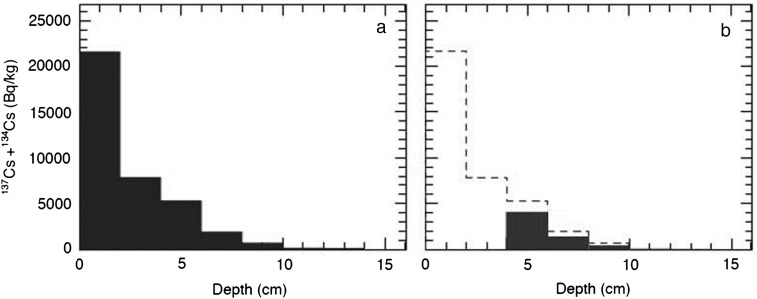
Decontamination of the rice field [1,2]. Radioactive Cs was only adsorbed onto the fine clay part of the soil; hence, it took time to sediment when water was introduced to the field and mixed with the surface soil. After mixing the surface soil with water, first the larger particles settled out, but the fine particles remained suspended in the supernatant. At this stage the fine particles suspended in the water were separated off into the ditch prepared next to the farming field, leaving most of the non-contaminated soil behind. Through this method, >80% of the radioactivity was removed: a: before treatment, b: after the removal of the supernatant. The radioactive Cs remained on the bottom or the walls of the ditch and hardly moved. When the ditch was filled in with non-contaminated soil, most of the radioactivity was shielded (M. Mizoguchi et al.).